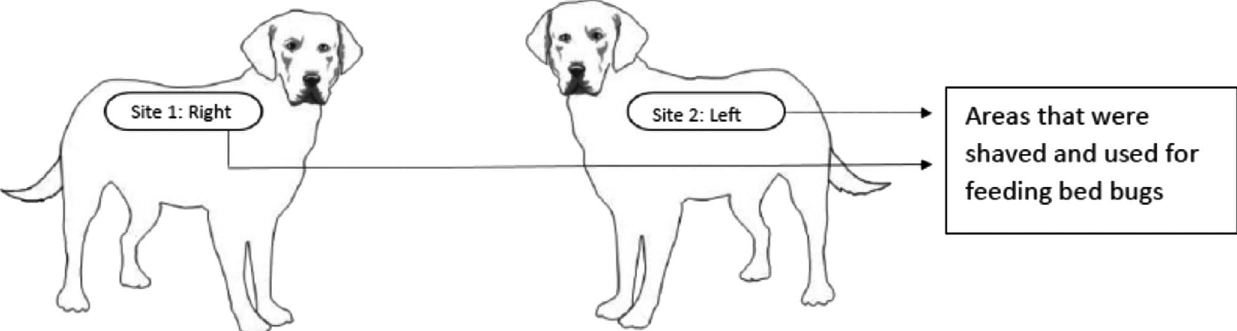
Figure 1. Areas of feeding of the bedbugs on